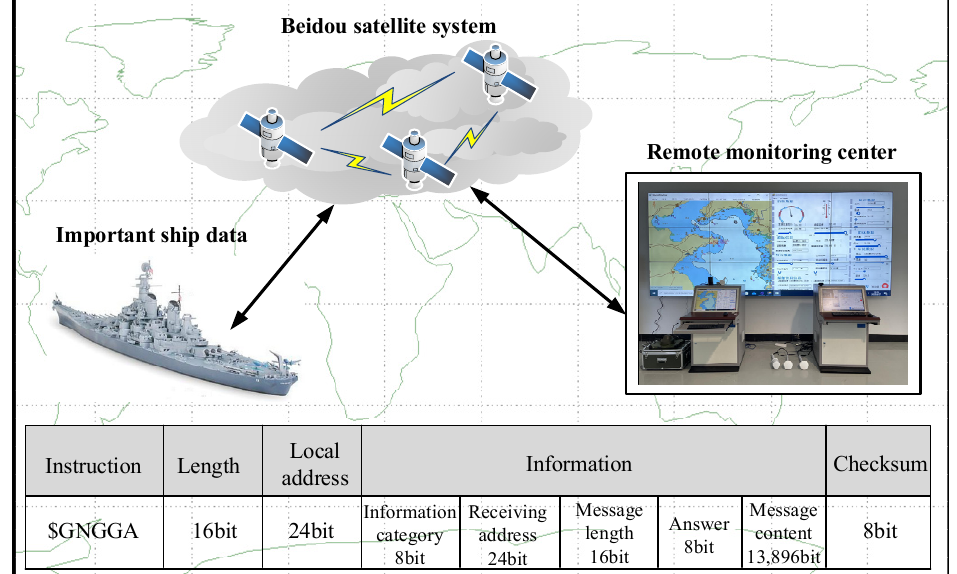
Figure 1. BeiDou satellite-information transmission mechanism.